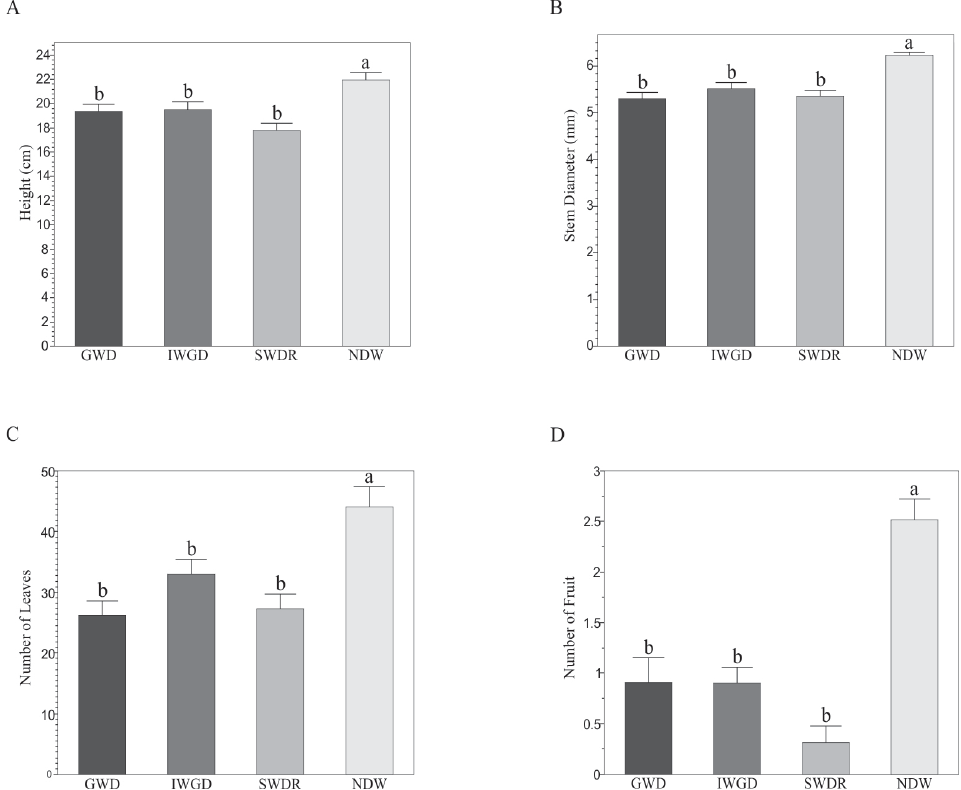
Figure 5. Results of plant performance of chili pepper grown under different water stress regimes. Results of the comparison of means ± S.E. by Tukey ′ s test of the morphological variables with the response in both types of soil added. ( A ) Height; ( B ) Stem diameter; ( C ) Number of leaves; ( D ) Number of fruit. In all cases, p = 0.05. Gradual water deficit (GWD), initial waterlogging with gradual water deficit (IWGD), sudden water deficit with gradual recovery (SWDR), no deficit of water (NDW).